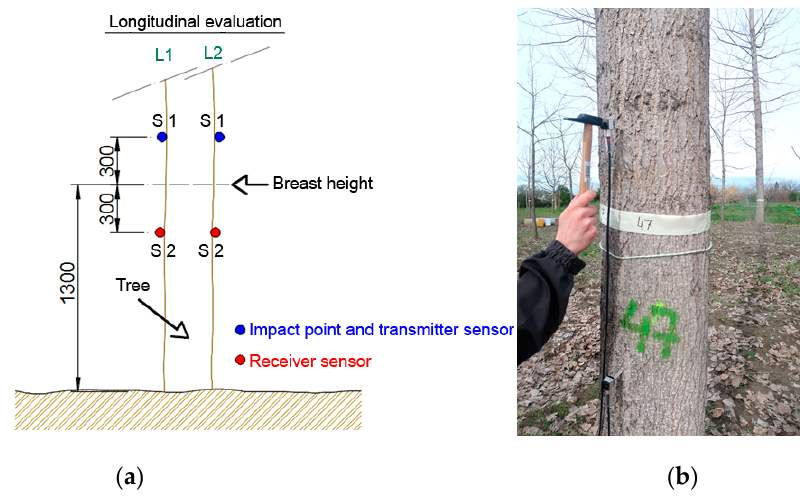
Figure 1. Time of Flight (ToF) inspection on the standing trees along directions L1 (N) and L2 (S). ( a ) Experimental setup; ( b ) Picture of a field test. Distances in mm.